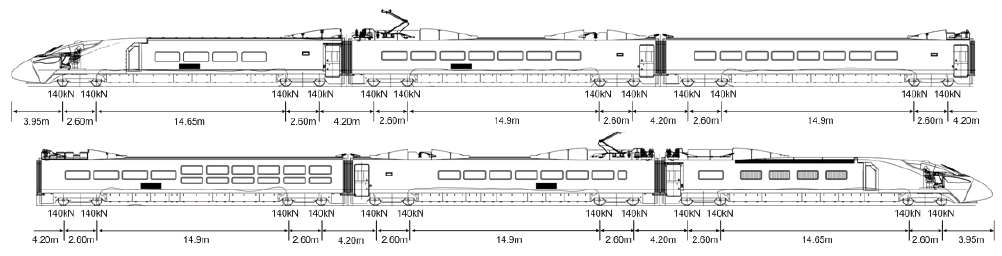
Figure 2. Axial spacing and loading of the high-speed train.